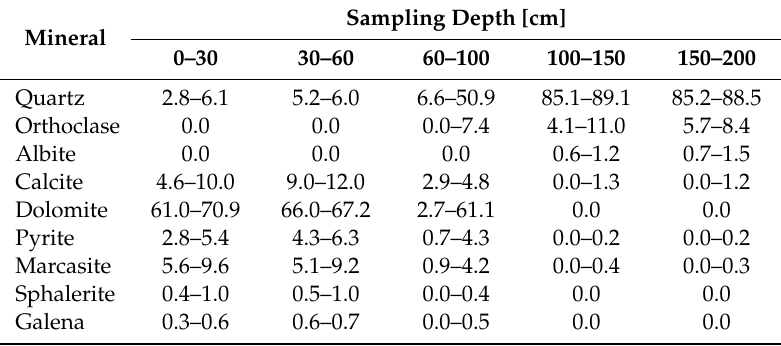
Table 1. Minerals of fluvial sediments in the Biała River valley [%] (after